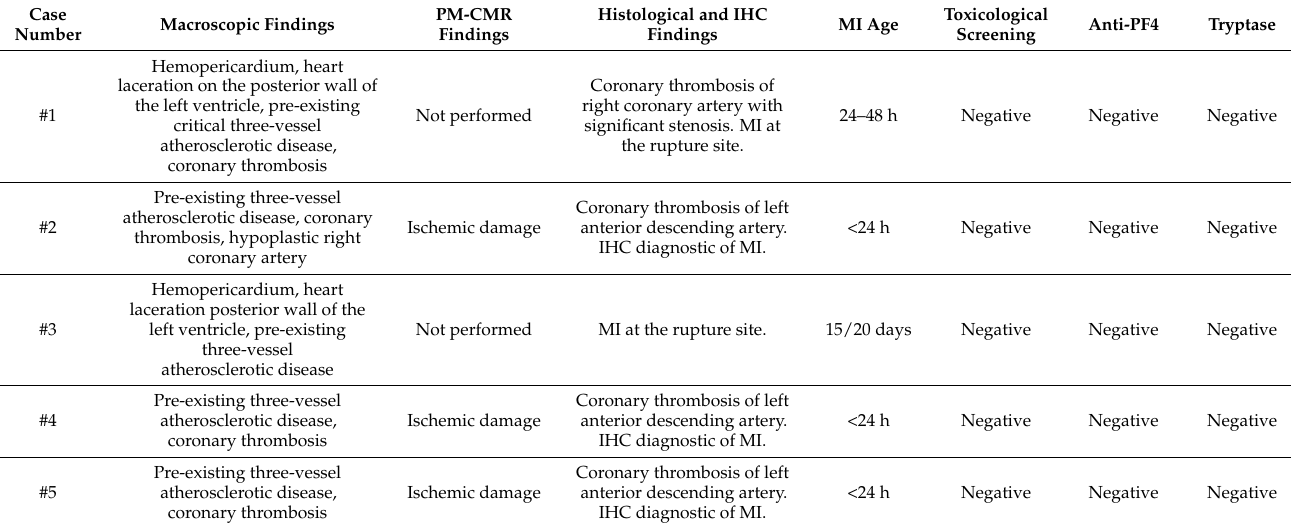
Table 2. Autoptic, radiological, histological, and laboratory